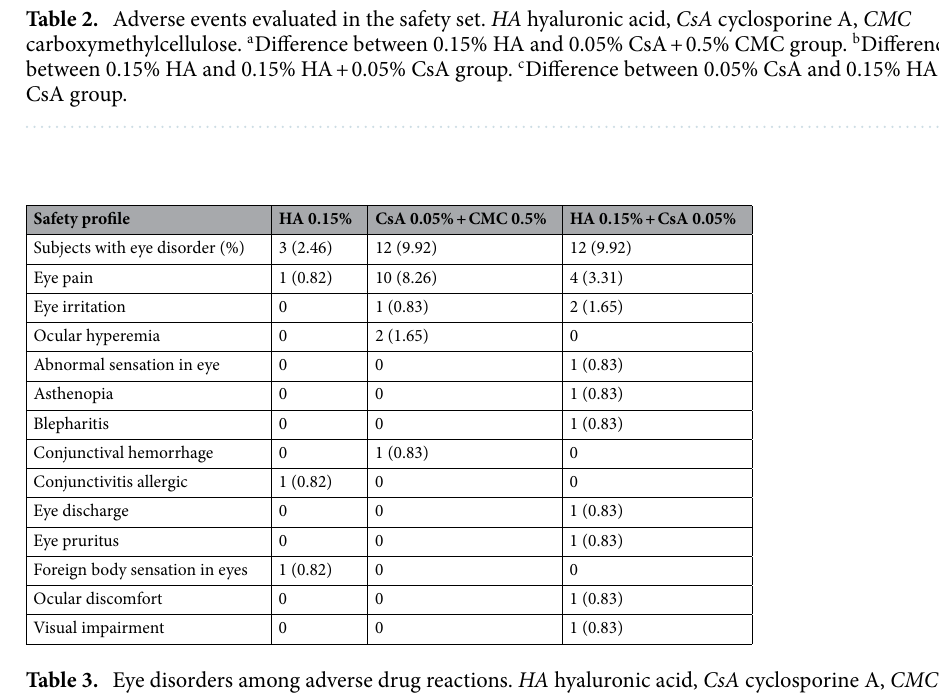
Table 3. Eye disorders among adverse drug reactions. HA hyaluronic acid, CsA cyclosporine A, CMC carboxymethylcellulose.